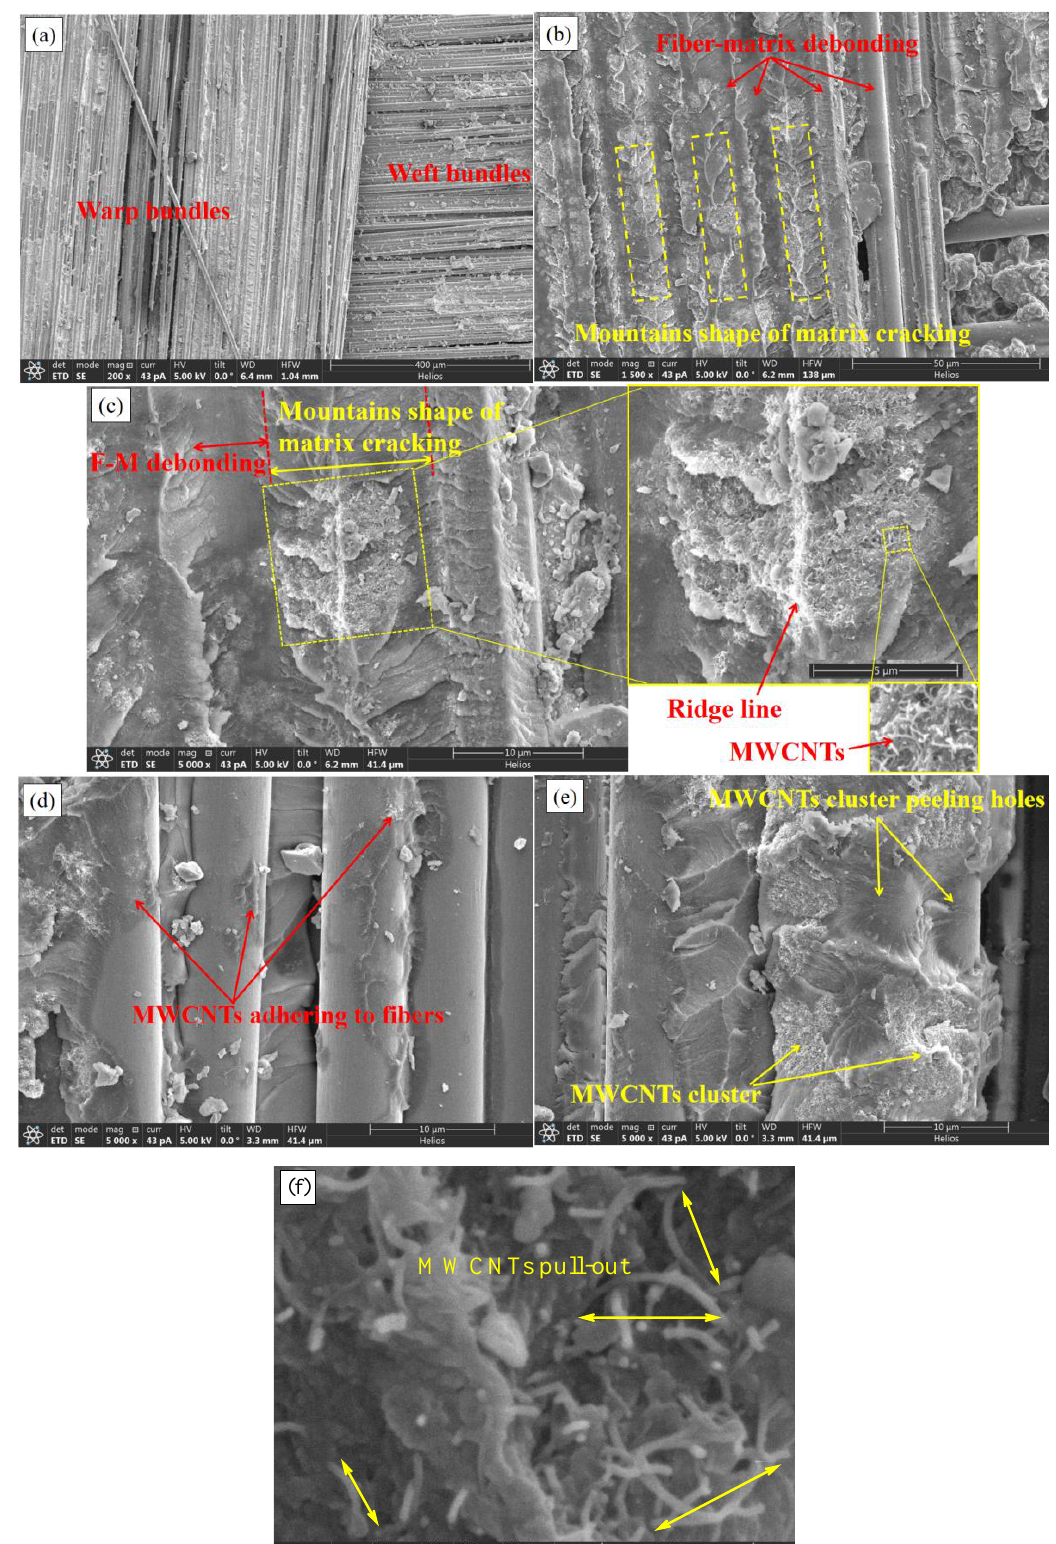
Figure 14. Meso- and micro-scale SEM photos of the fracture appearance of a MWCNTs toughening specimen. ( a ) magnified 200 times, ( b ) magnified 1500 times, ( c – e ) magnified 5000 times, ( f ) magnified 10000 times.